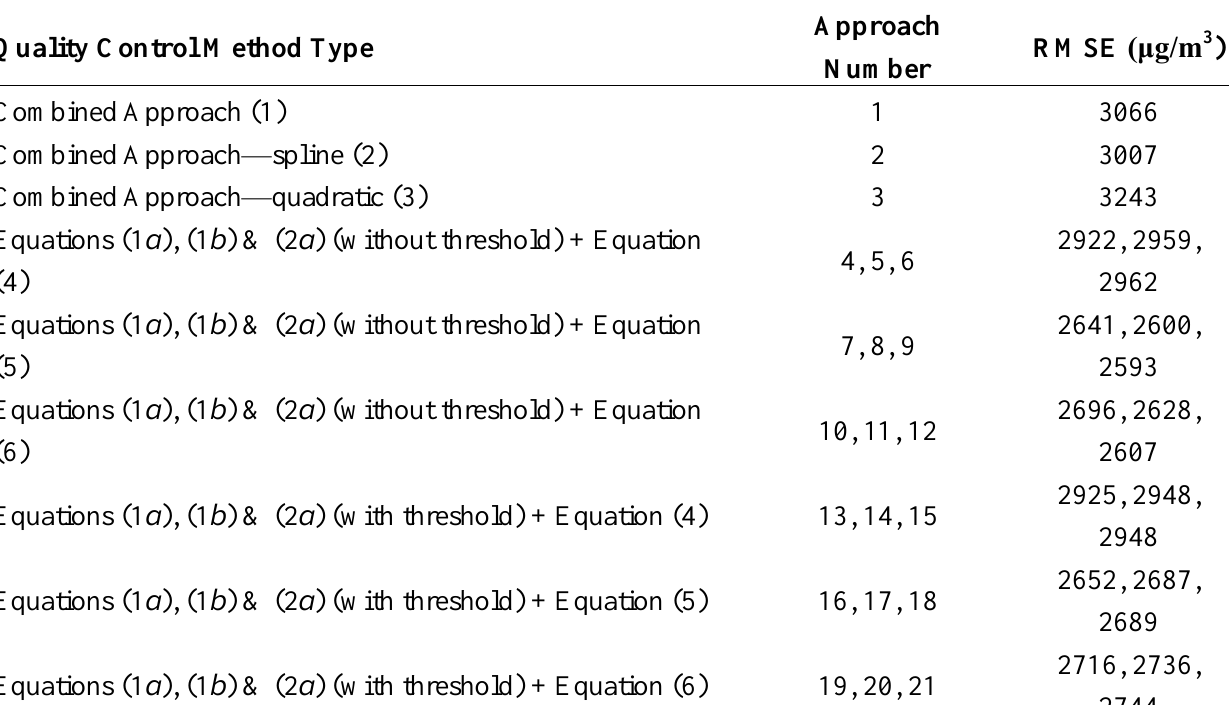
Table 3. Summary of different overall pDR-1000 adjustment approaches comparing the RSE